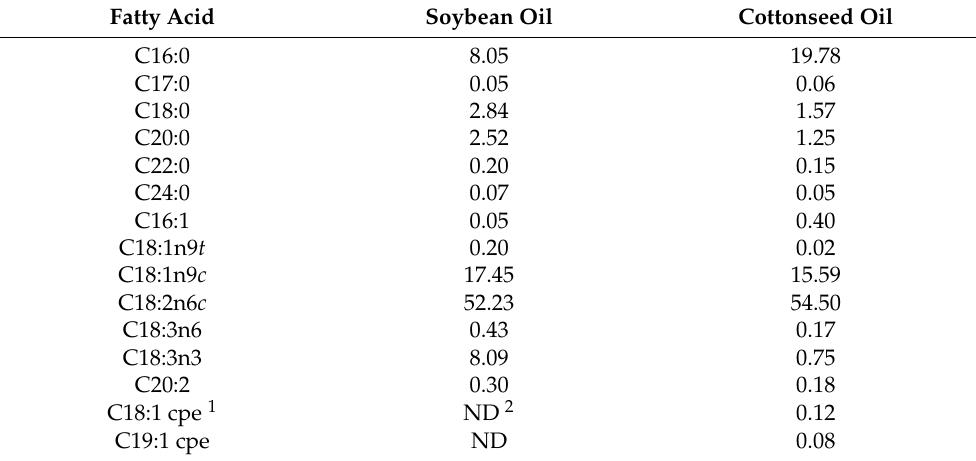
Table 1. Fatty acid composition of soybean oil and cottonseed oil (g/100 g of total fatty acids).